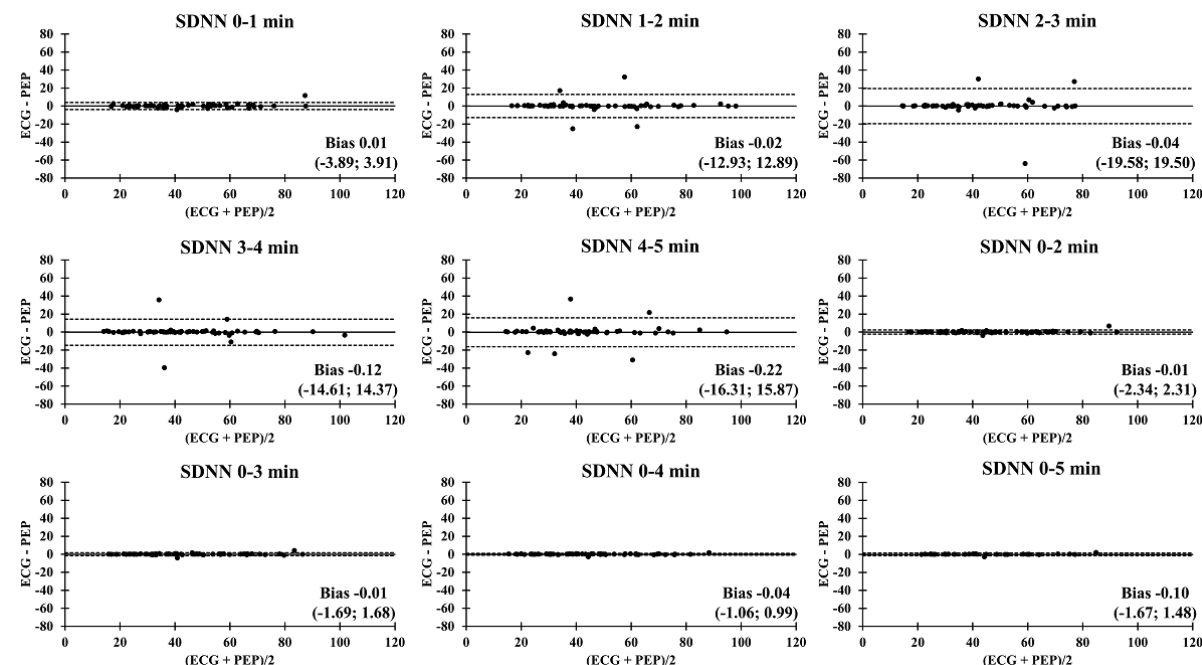
Figure 4. Bland-Altman analysis comparing the ECG and Pulse Express PRO measurements in ultra–short-term and short-term recordings of standard deviation of normal R-R intervals (SDNN). The solid line represents the mean difference and the upper and lower dashed lines represent the upper and lower limits of agreement (± 1.96*SD). ECG: electrocardiogram; PEP: Pulse Express PRO.